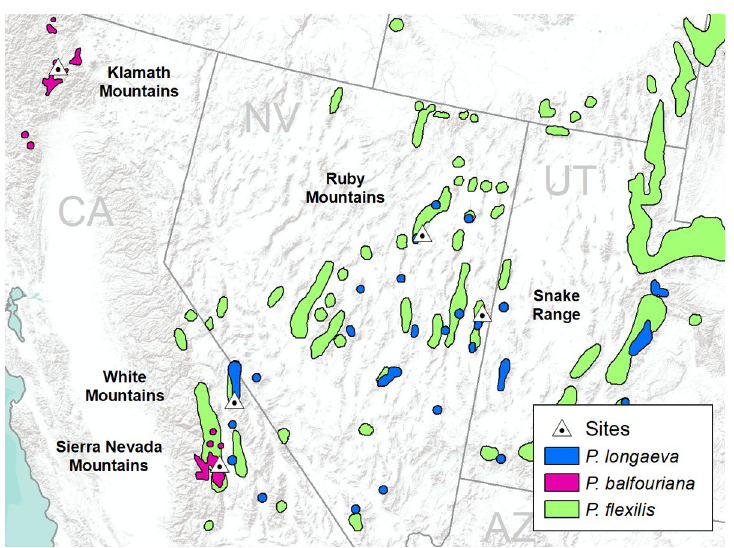
Fig 1. Distributions of Great Basin bristlecone pine ( Pinus longaeva ), foxtail pine ( P . balfouriana ), and limber pine ( P . flexilis ), and sample site locations (see Table 1). Pine distributions are based on Little (1971)